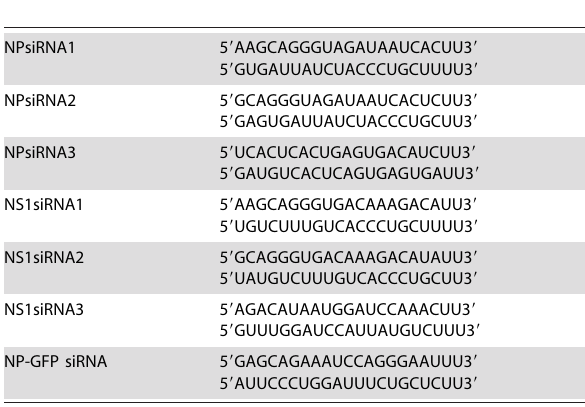
Table 2. Sequences of siRNAs used in the